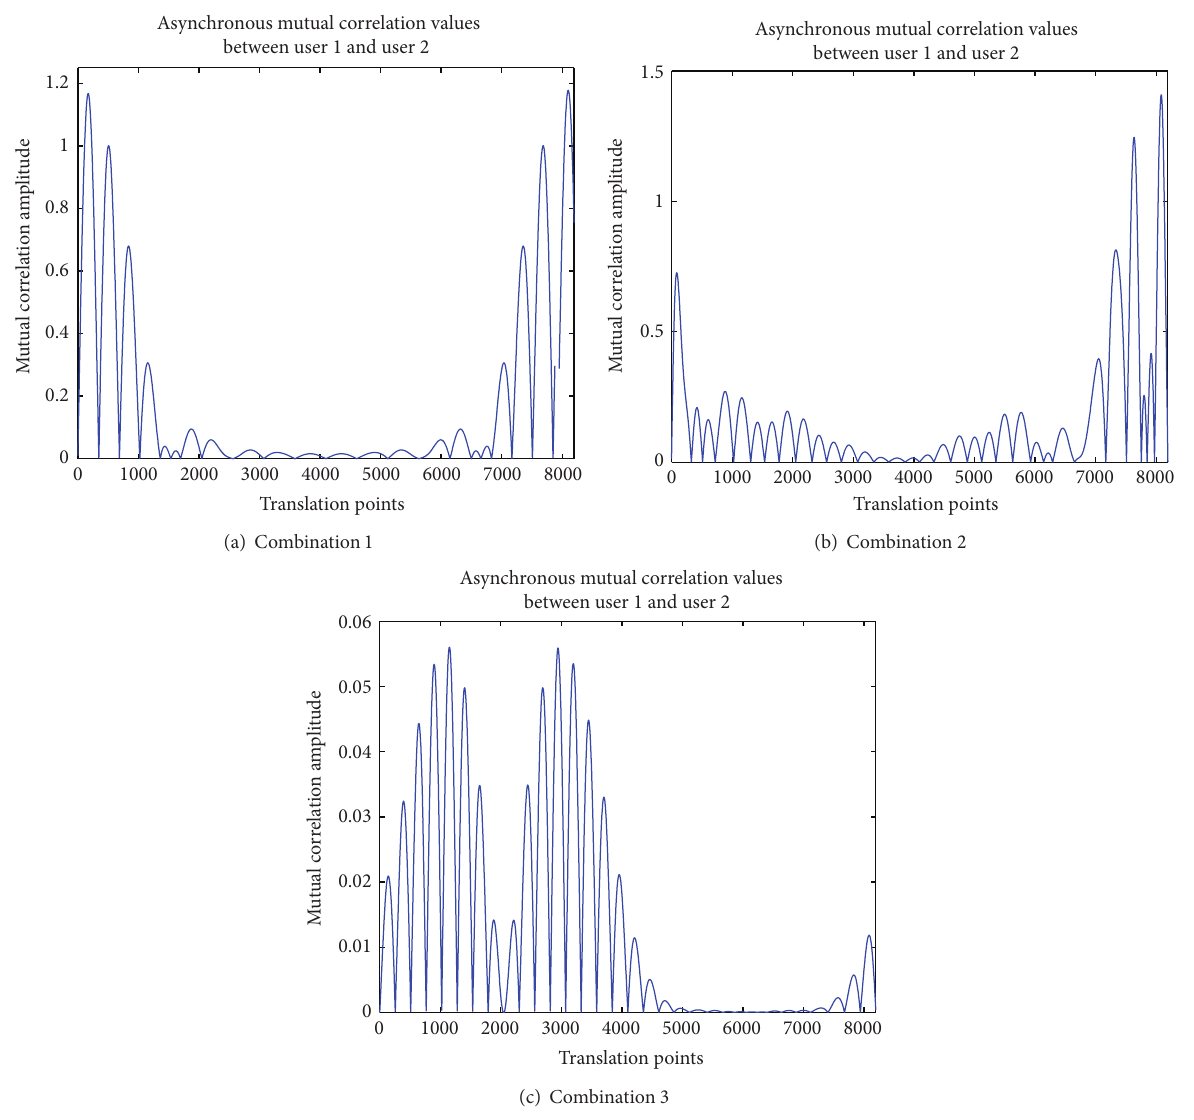
Figure 6: Asynchronous mutual correlation values of three